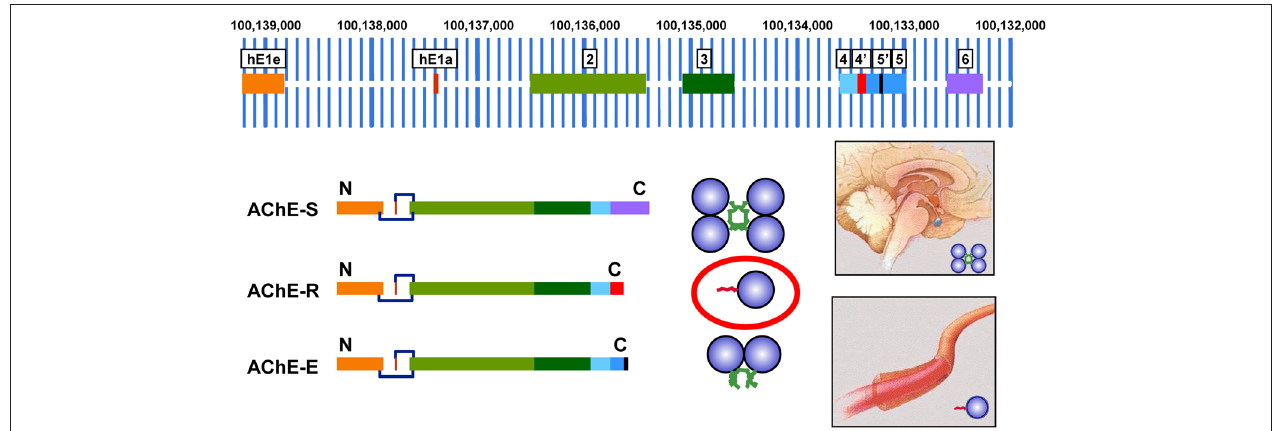
in the circulation, albeit being less stable than AChE-S. Both AChE variants are associated with stress-inducible hematopoiesis. The red-labeled C-terminus of AChE-R represents the hematopoietic peptide ARP [Grisaru et al.